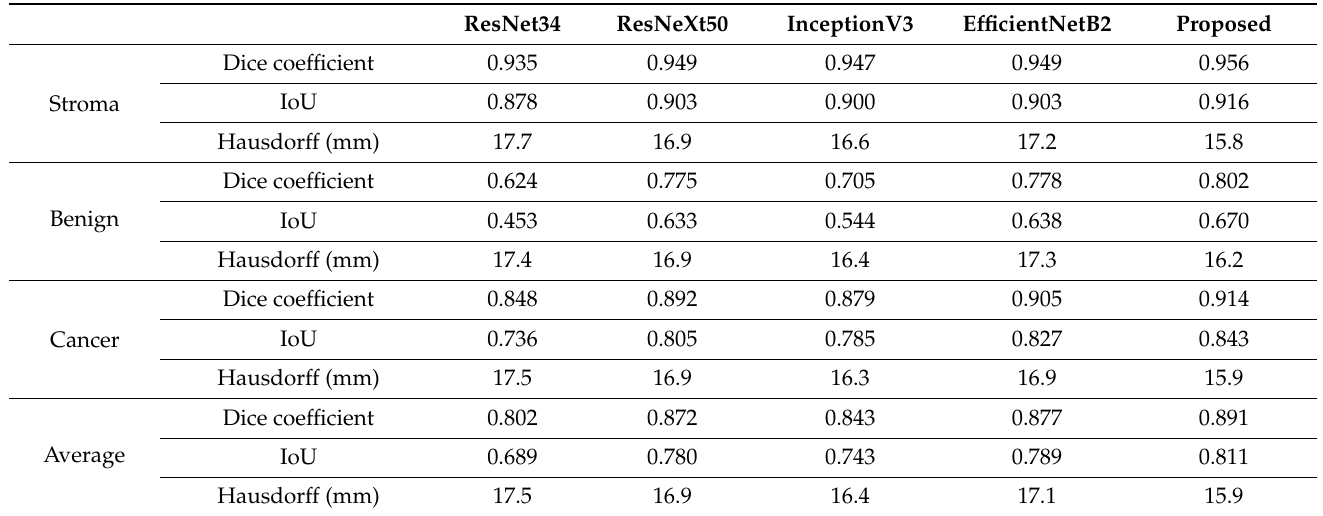
Table 2. Comparative analysis of the performance of the proposed model with some existing methods based on Dice score, IoU, and Hausdorff on a test dataset. ResNet34 ResNeXt50 InceptionV3 EfficientNetB2